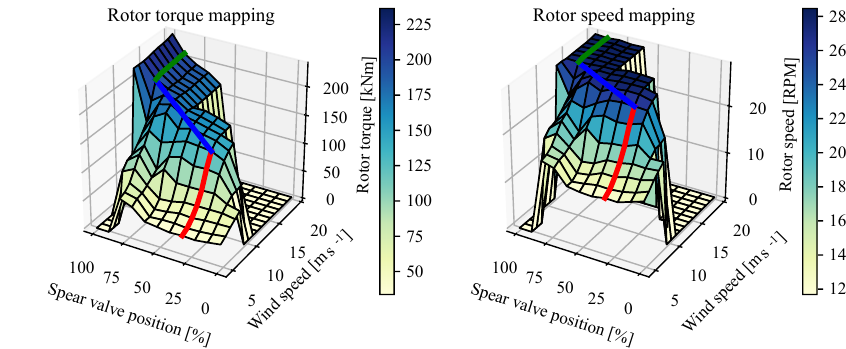
Figure 20. Steady-state rotor torque and speed at predefined spear valve positions (nozzle areas) and wind speed conditions. The red line indicates the operation strategy at fixed spear valve position in the below-rated region, whereas the blue trajectory indicates active spear valve position control towards rated conditions. The effect of blade pitching is indicated in green.